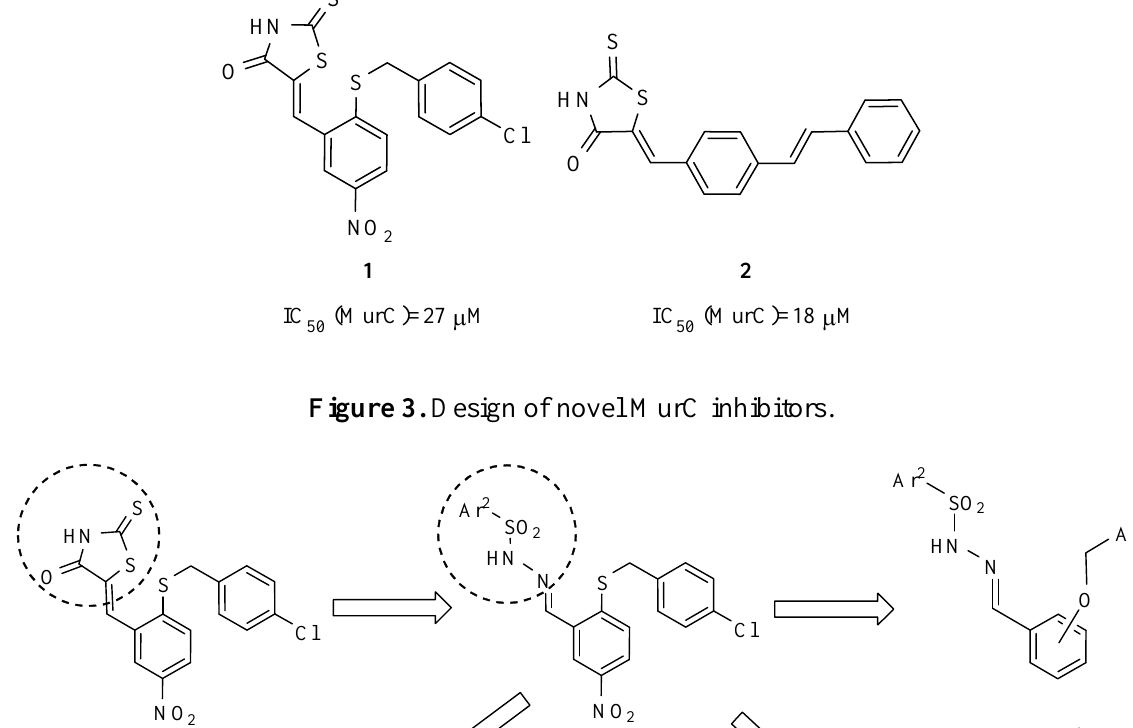
Figure 2. Rhodanines 1 and 2 which were used as a starting point for further synthetic modifications.